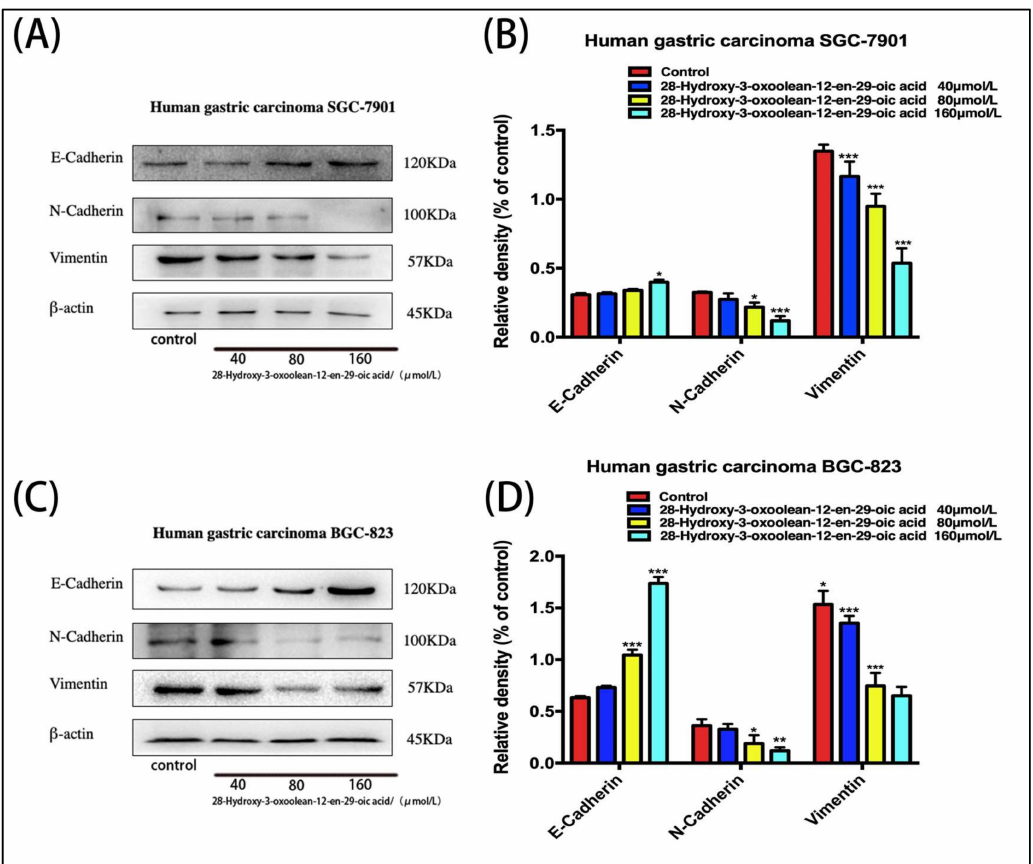
Figure 6. ( A , C ) Changes in epithelial–mesenchymal transition (EMT) biomarker expression levels following 28-hydroxy-3-oxoolean-12-en-29-oic acid for 24 h were assessed by Western blotting. ( B , D ) The band intensities of E-cadherin, N-cadherin and vimentin relative to untreated control cells were quantified upon normalizing to β -actin expression, and are expressed as the mean ± standard deviation of three independent